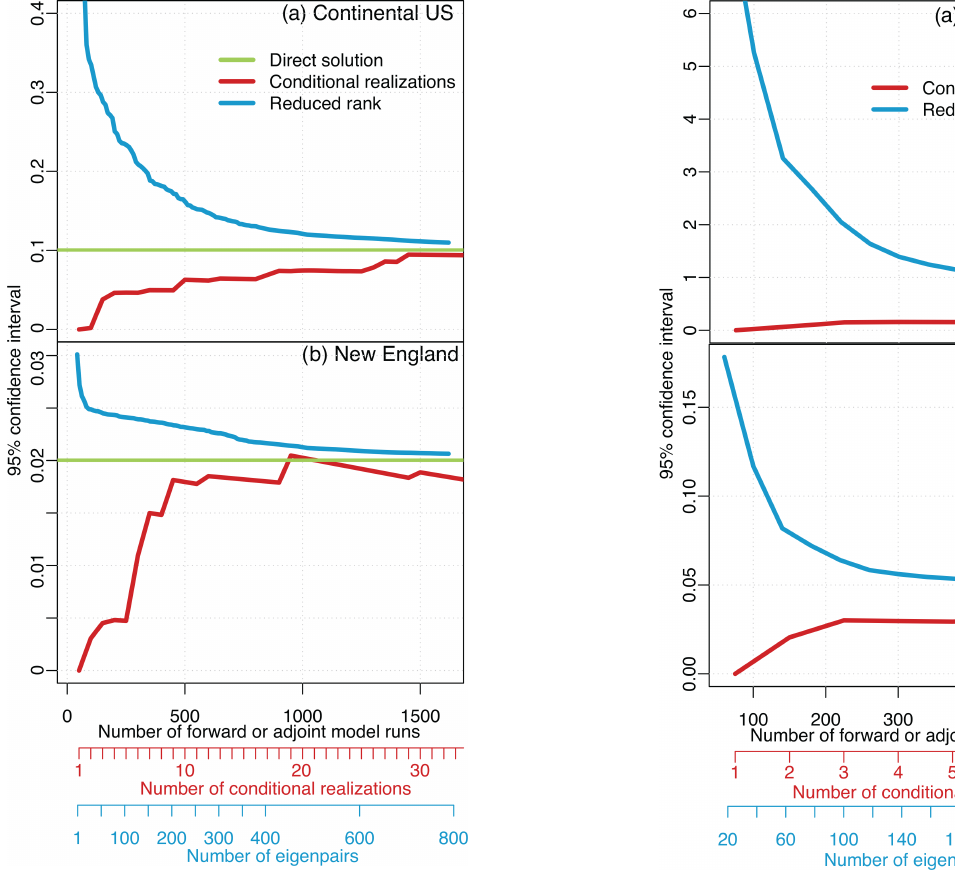
Figure 5. Estimated uncertainties for the full-year case study, anal- ogous to Fig. 4. The uncertainties estimated by the reduced-rank approach are consistently higher than the conditional realizations, though they begin to converge as the number of realizations and eigenpairs increases. Note that it is not possible to obtain a direct estimate for the uncertainties given the size of this case study, so we cannot evaluate the accuracy of the uncertainty estimates shown